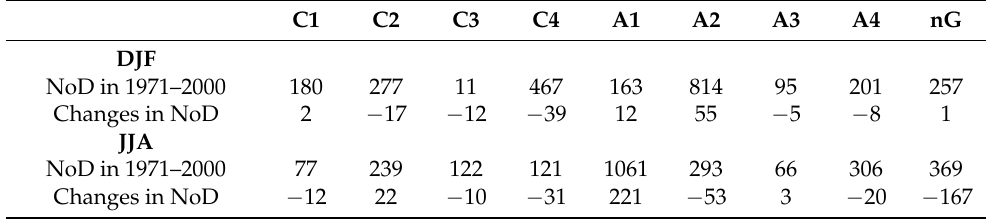
Table 4. Ensemble median of NoD with a particular WT in the near-present day (1971–2000, second row DJF, fifth row JJA), and ensemble median of differences in number of days with a particular WT between future climate conditions (2041–2070, RCP8.5) and near-present day (1971–2000; third row DJF, sixth row JJA). WTs are gathered regardless of the upper